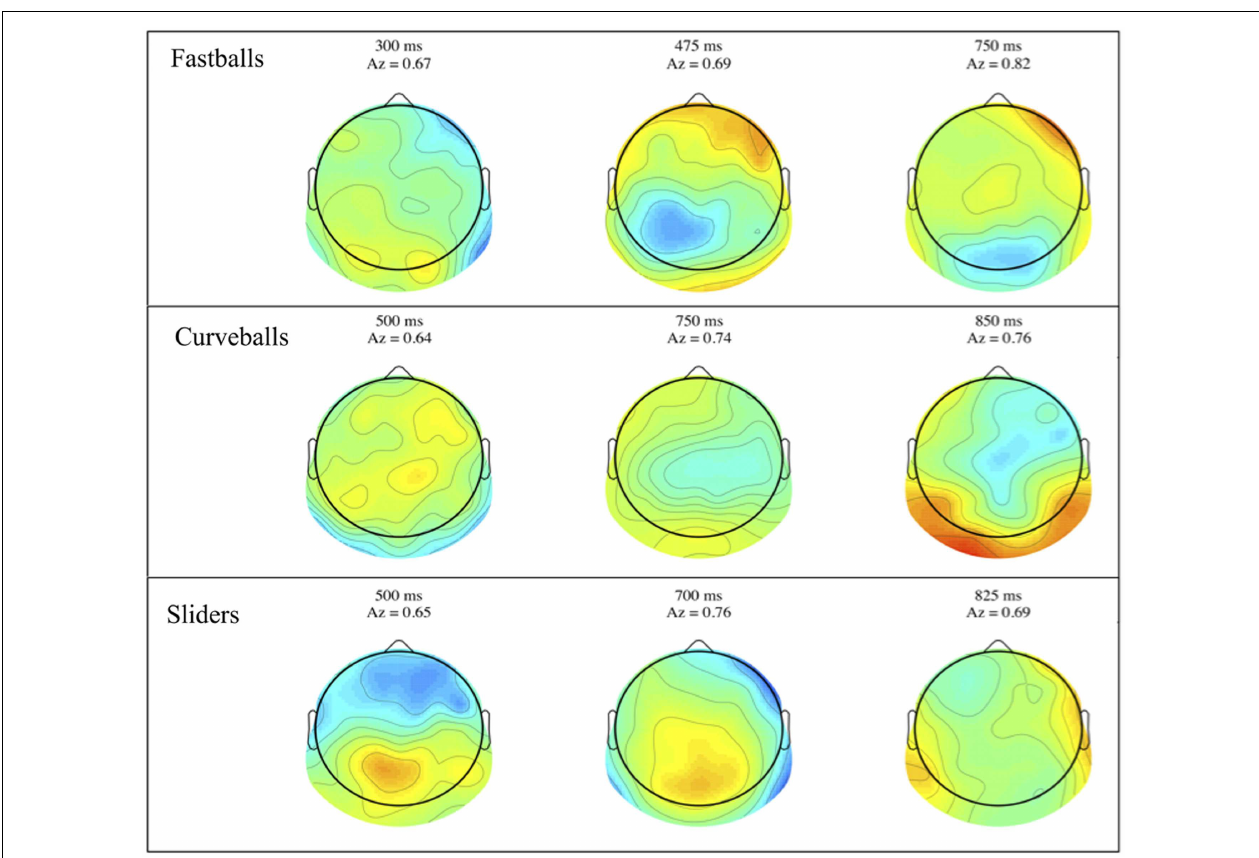
windows are shown for discriminating components estimated for those windows.The center time of each window is given above each plot together with that window’s discrimination ( A z ) value.